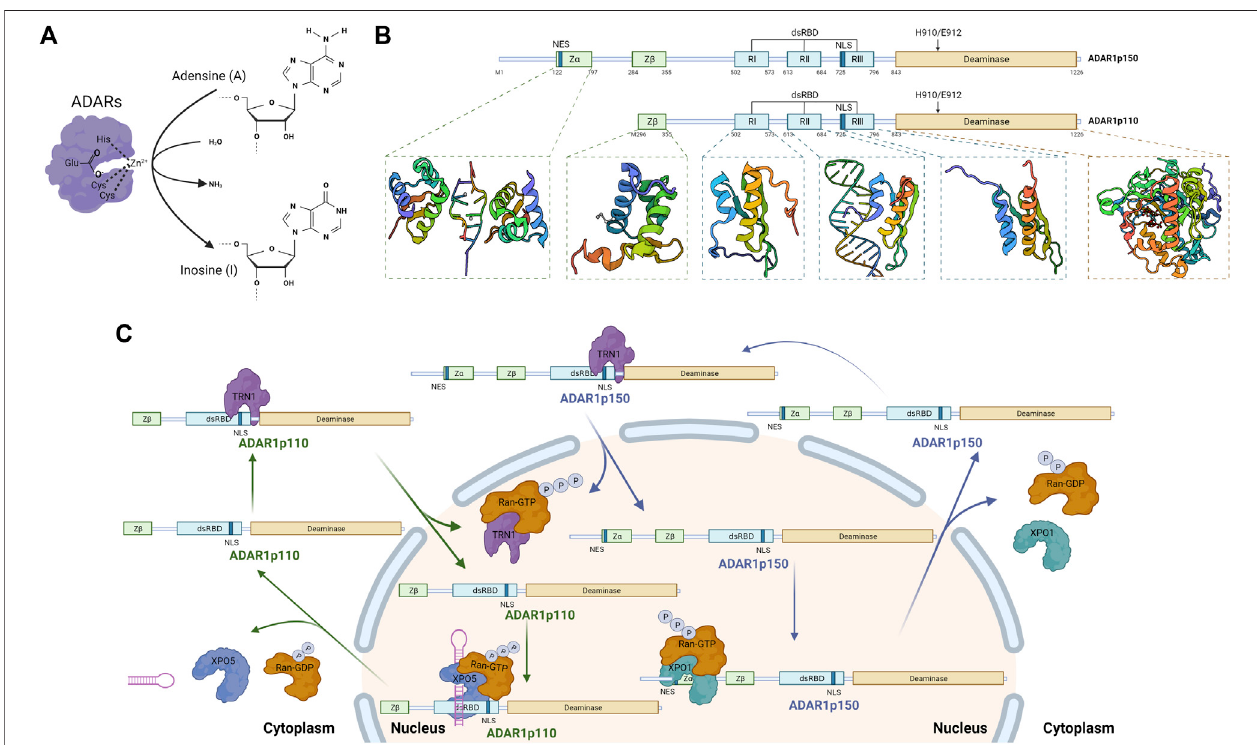
FIGURE1| Catalyticfunction,domainorganization,andshuttlemechanismofAdenosineDeaminaseActingonRNA1(ADAR1)(CreatedwithBioRender.com). (A) RNA editing by ADARs. Alternative RNA editing by C6 deamination of adenosine (A) in the double-stranded RNA region to generate inosine (I), catalyzed by ADARs enzymes. (B) Schematic ofthe domain structure oftwo isoforms ofADAR1. ADAR1p150 and ADAR1p110 share identical sequence except foran additional N-terminal sequence for ADAR1p150, including an additional Z α domain (PDB: 2GDB) (Placido et al., 2007) and the NES which allows for both cytoplasmic and nuclear localization. Both contain a Z β domain (PDB: 1XMK) (Athanasiadis et al., 2005) that mainly mediate Z-DNA/RNA binding, three dsRBDs domain (PDB: 2LJH, 2L2K, 2MDR)(Ste fl etal.,2010;Barraudetal.,2012;Barraudetal.,2014)thatmediatedsRNAbindingandhomodimerization,andadeaminasedomain(PDB:1ZY7)(Macbeth et al., 2005) that is the catalytic center of ADAR1. (C) Cellular localization of ADAR1. XPO1 binds to NES located within the Z α structural domain and regulates nuclear export of ADAR1p150 in the presence of RAN-GTP. Nuclear import of ADAR1p110 is mediated by binding of TRN1 to dsRBD3. NLS located in the third dsRBD, a domain common to both ADAR1 isoforms, binds with TRN1 to assist in the targeting of ADAR1 in the nucleus.